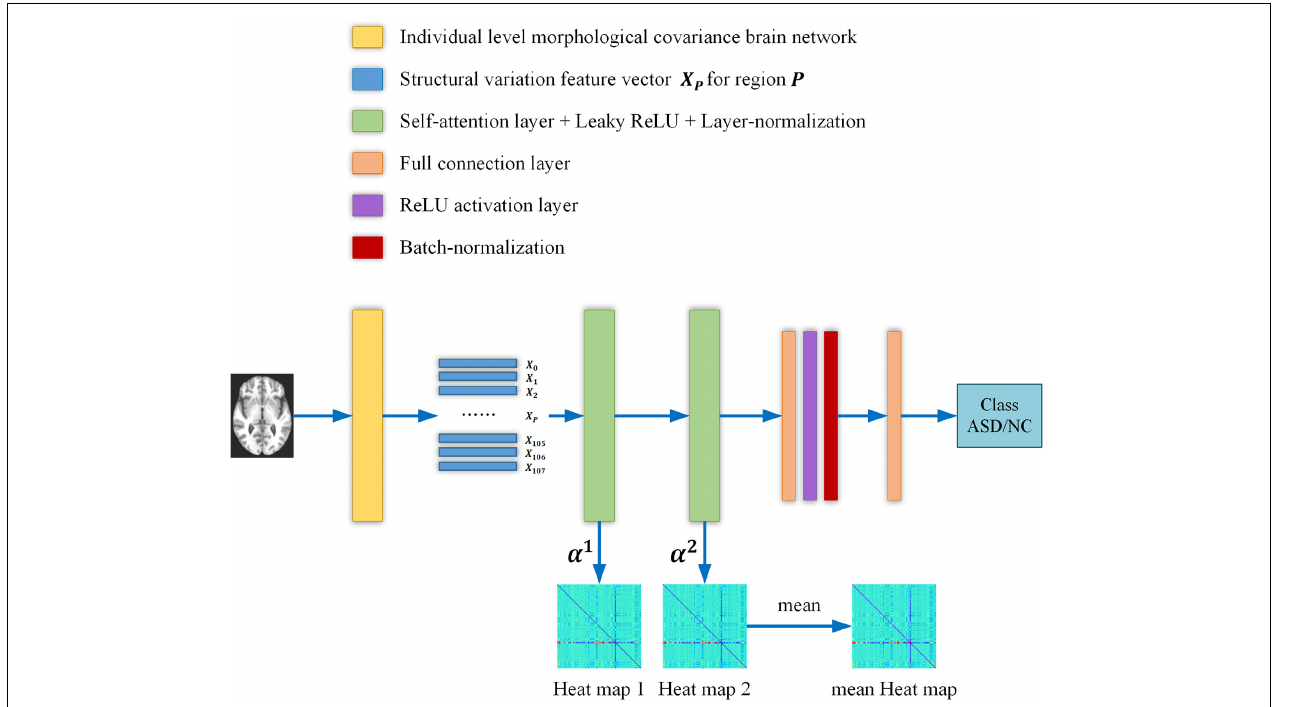
FIGURE 1 | The overall flow chart of our study. Briefly, the individual level morphological covariance brain network is first constructed according to the SRI24 atlas and gray matter volume map of each subject. The above morphological covariance brain network is used to extract interregional structural variation vectors to characterize the interregional morphological relationship. Then the vectors are fed into two self-attention layers classification neural networks. Meanwhile, the contribution of each region for classification is obtained from the self-attention coefficients map of each layer. Finally, two heat maps are averaged to obtain a mean output heat map for diagnosis biomarker identification.